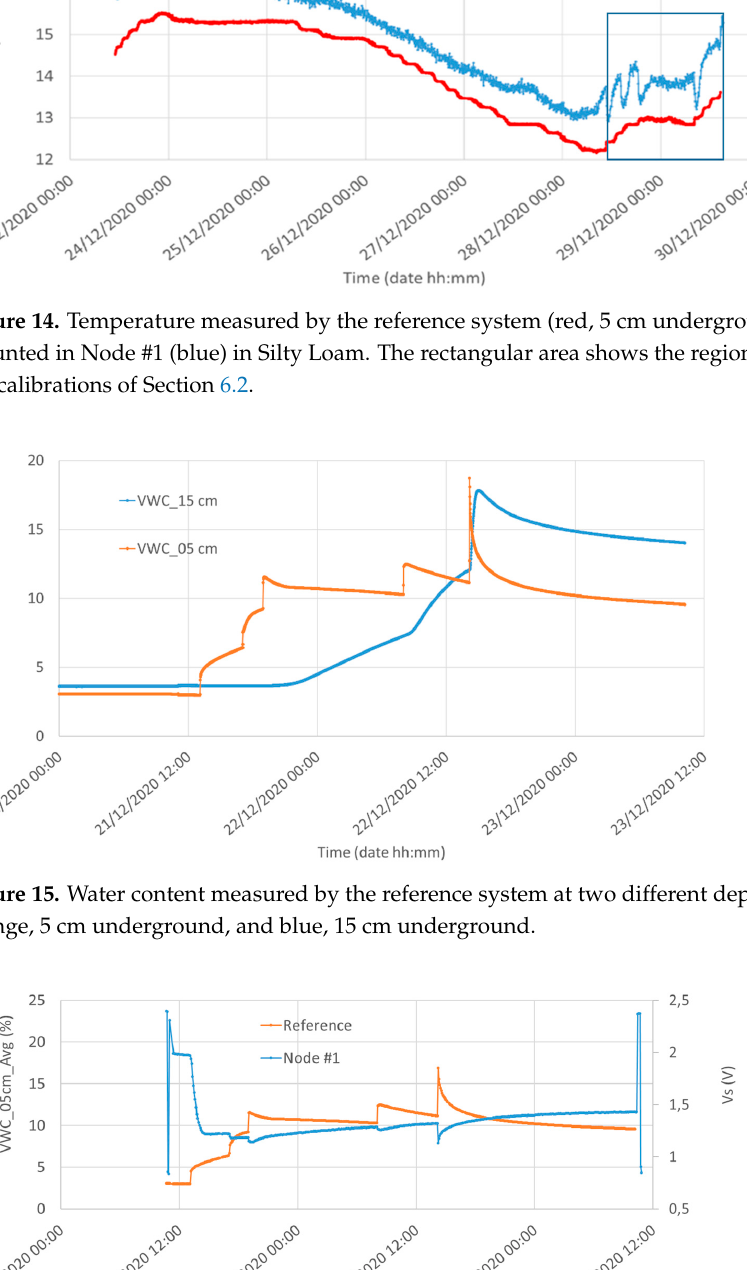
Figure 15. Water content measured by the reference system at two different depths in Loamy Sand: orange, 5 cm underground, and blue, 15 cm underground.